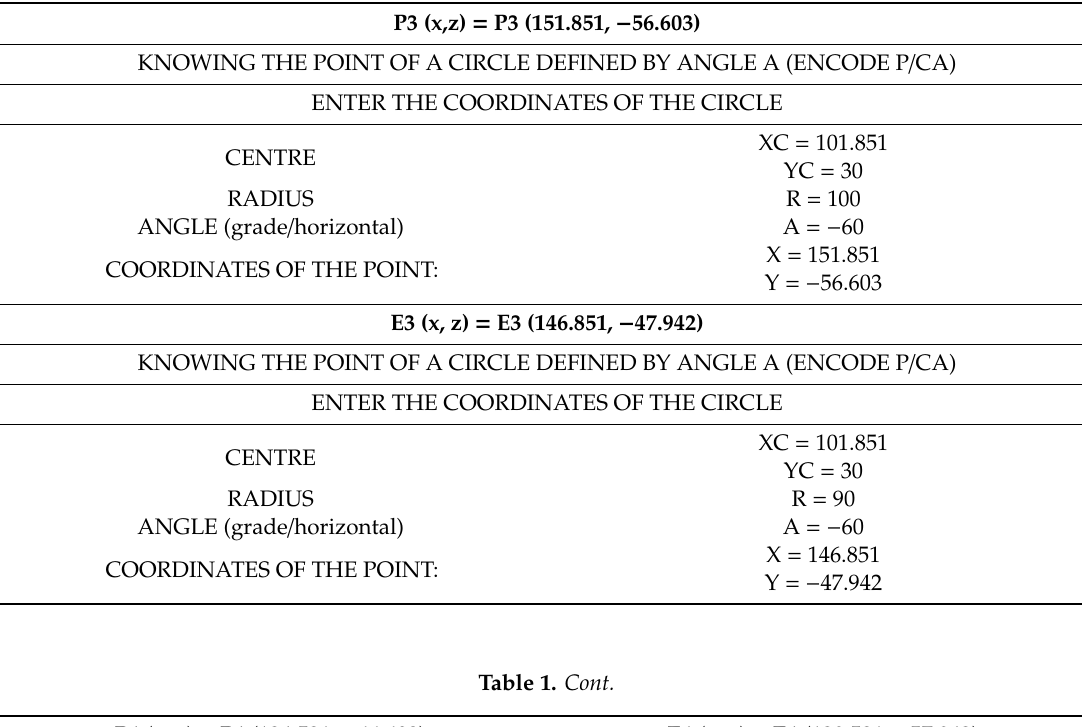
Table 1. The characteristic points obtained with the help of the utility